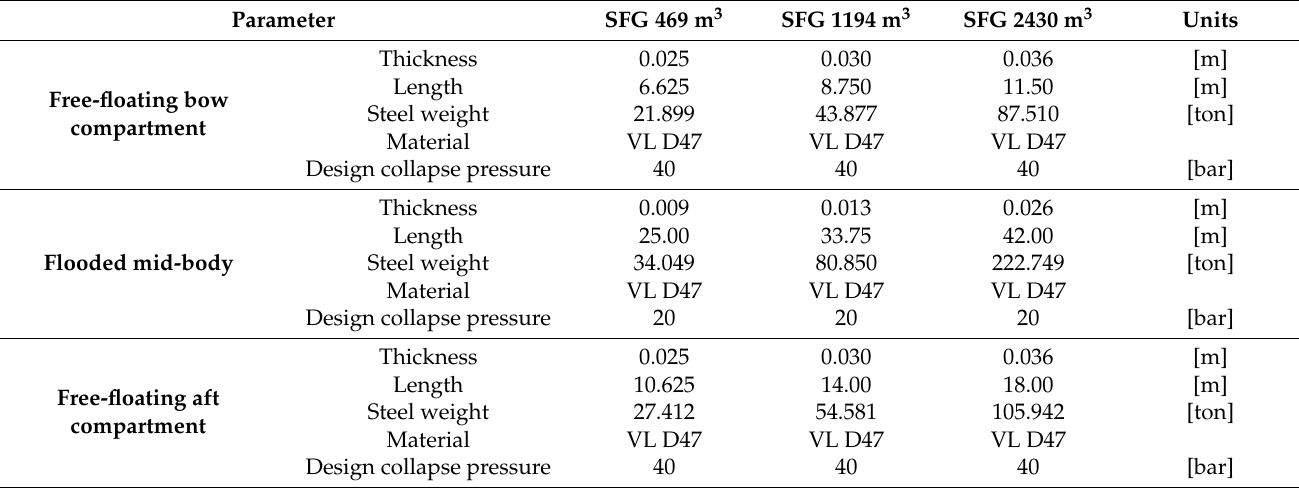
Table 4. SFG baseline design of the external